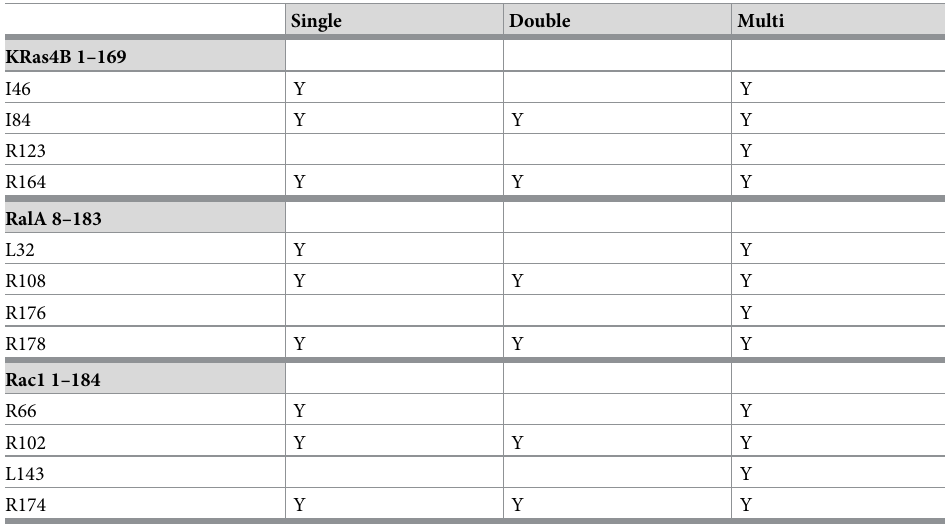
Table 4. Positions selected for substitution with non-optimal codons. Single Double